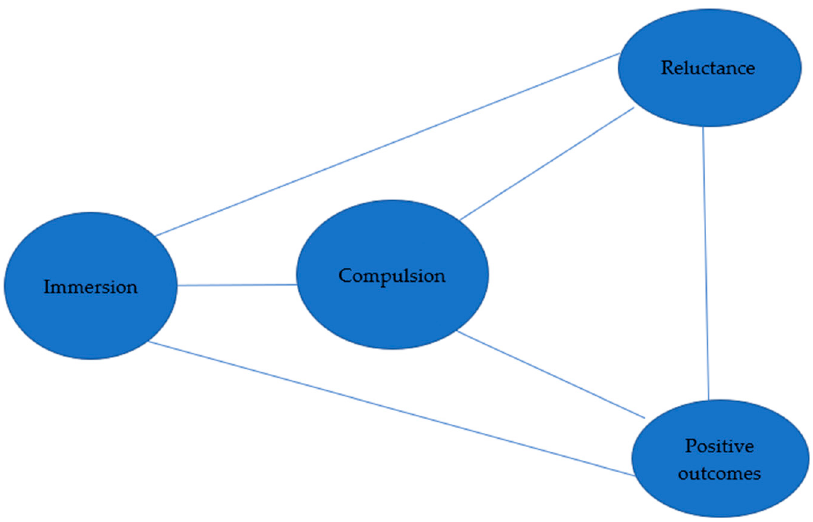
Figure 1. A thematic map of the relationships among the four main themes associated with the experience of engaging with the family history.